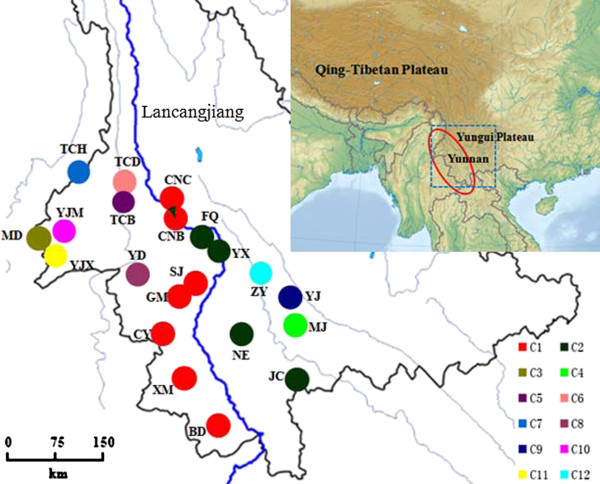
The geographical distribution of 12 rpl32-trnL chlorotypes in the 21 C. taliensis populations.  The Lancang River is indicated in blue, while red circle showes the range of the species.